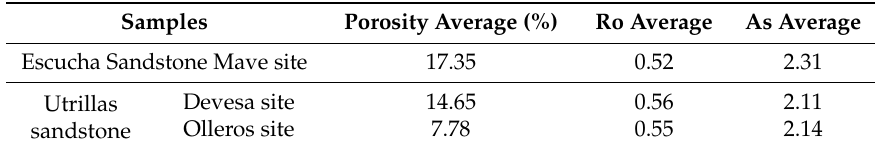
Table 1. Optical porosity, roundness (Ro) and aspect ratio (As) measured by OIA-OPM of sandstones thin sections.